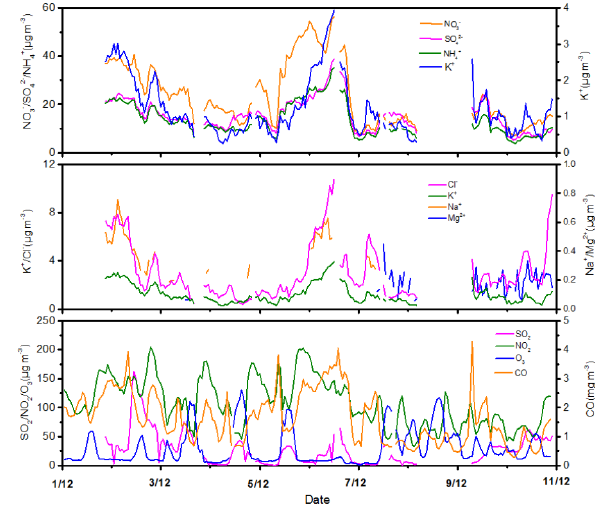
Figure 7. Temporal variations of chemical species in particles from 1 to 10 December